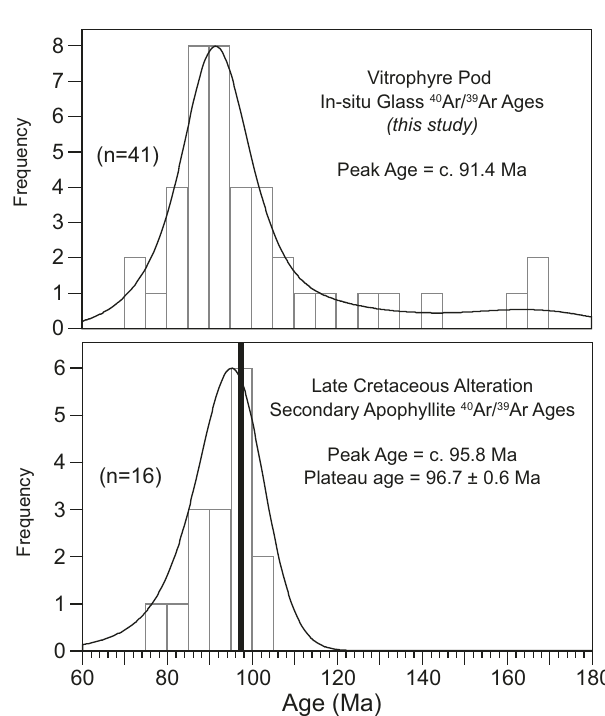
Fig. 6 | Regional summary of Ar/Ar alteration ages from Victoria Land, Ant- arctica. Kernel density plot and histogram of in situ 40 Ar/ 39 Ar ages for glass from vitrophyrepodsamplesoftheButcherRidgeIgneousComplex(BRIC)comparedto total fusion and plateau 40 Ar/ 39 Ar ages for secondary apophyllite minerals within Jurassic Ferrar Large Igneous Province rocks from Northern and Southern Victoria Land that constrain the timing of regional Late-Cretaceous alteration 39,40